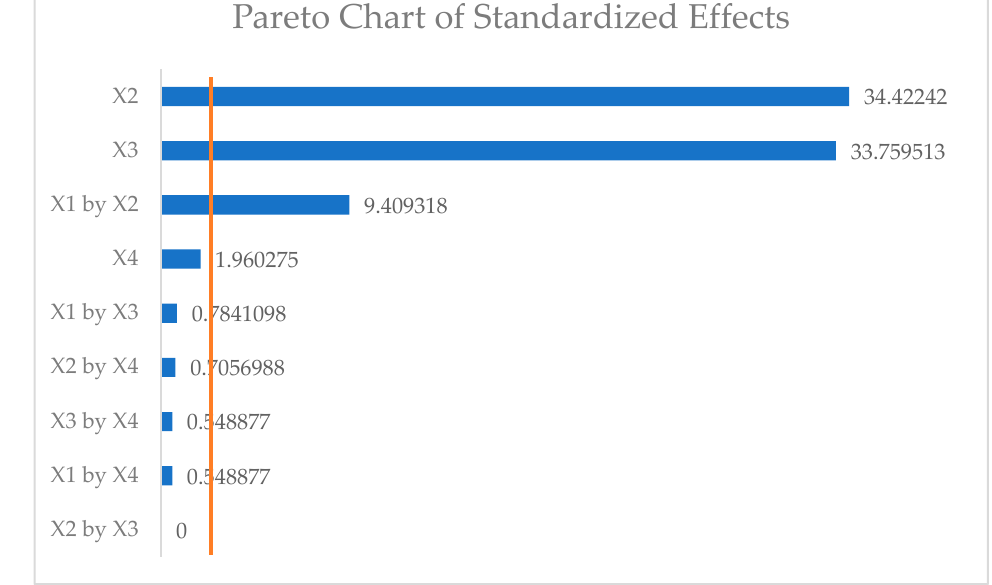
Figure 2. Pareto chart, the t -test values of factors and their paired interactions ( p = 0.5).